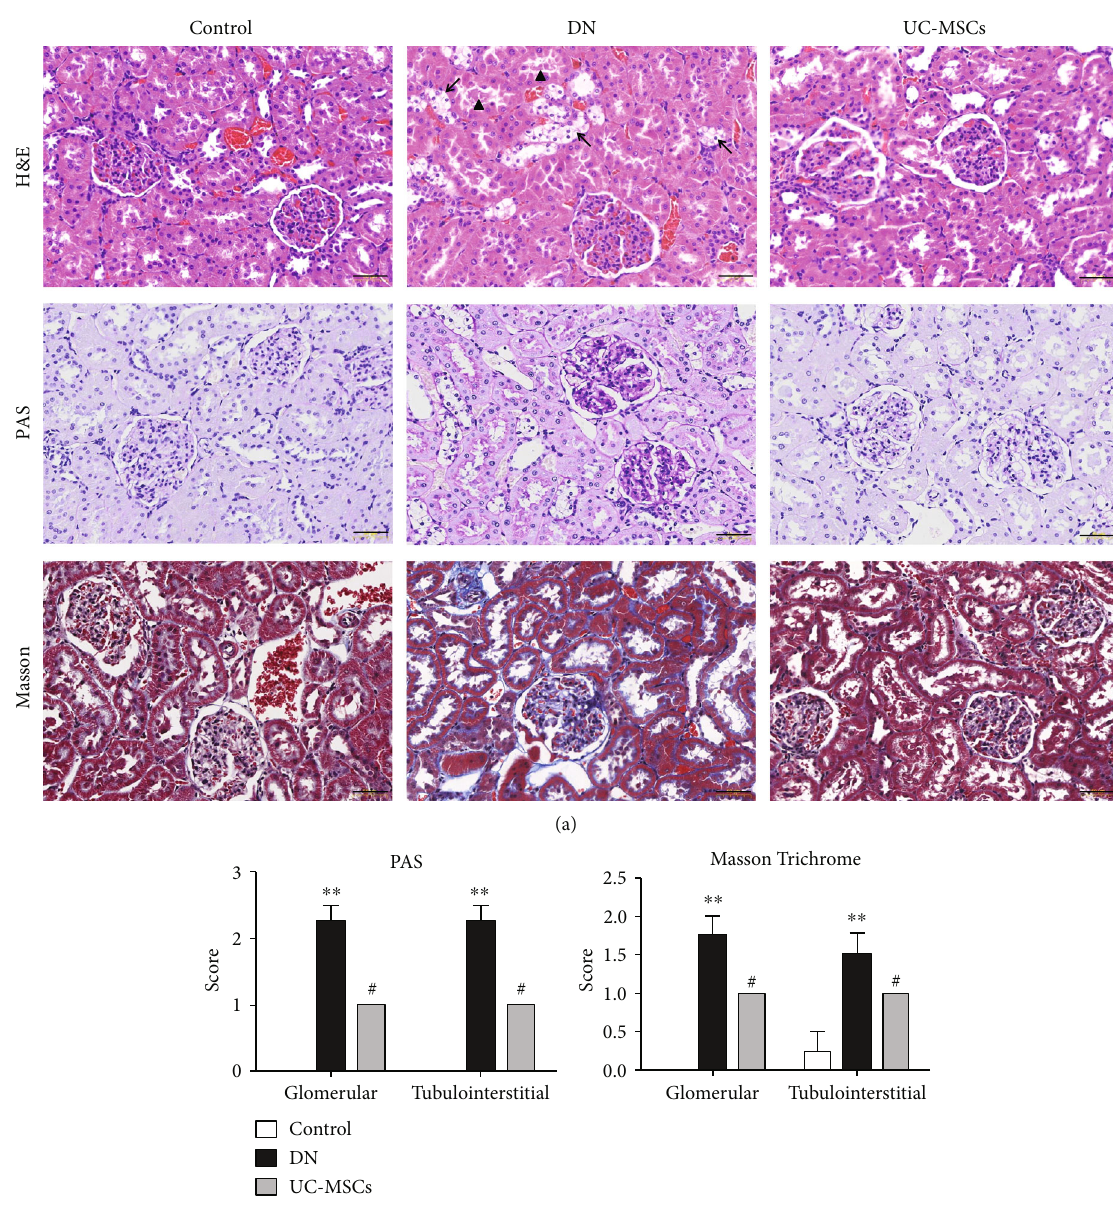
Figure 3: Histological examinations of renal tissues were conducted in rats. Pathological changes of kidney were evaluated by H&E, PAS, and Masson Trichrome staining (a), scale bar = 50 μ m (black arrows indicate vacuolation of tubular epithelial cells, and arrowheads indicate cylinder in H&E staining). Semiquantitative analysis of PAS and Masson Trichrome staining was conducted as previously described (b) ( n = 4~5 , ∗∗ p < 0 : 01 versus control group, # p < 0 : 05 versus DN